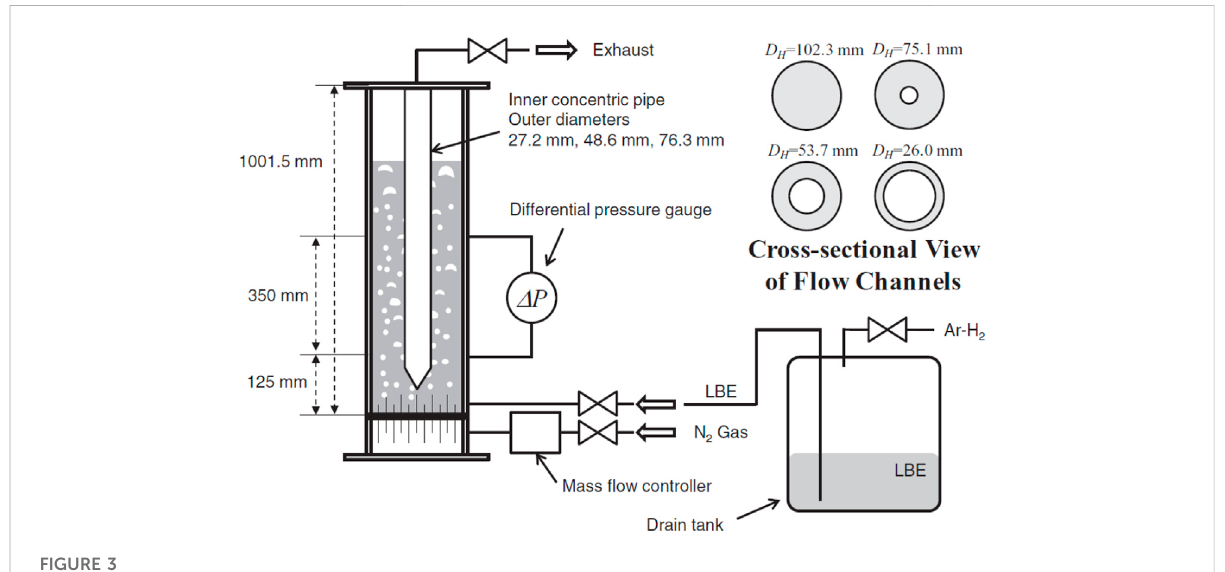
FIGURE 3 Diagram of Ariyoshi ’ s test facility (Ariyoshi et al.,